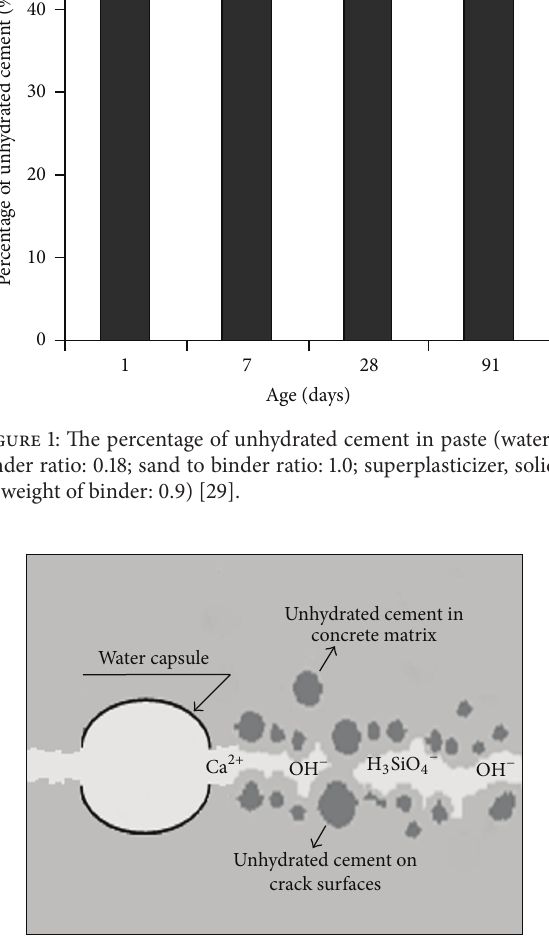
Figure 2: Schematic diagram of further hydration